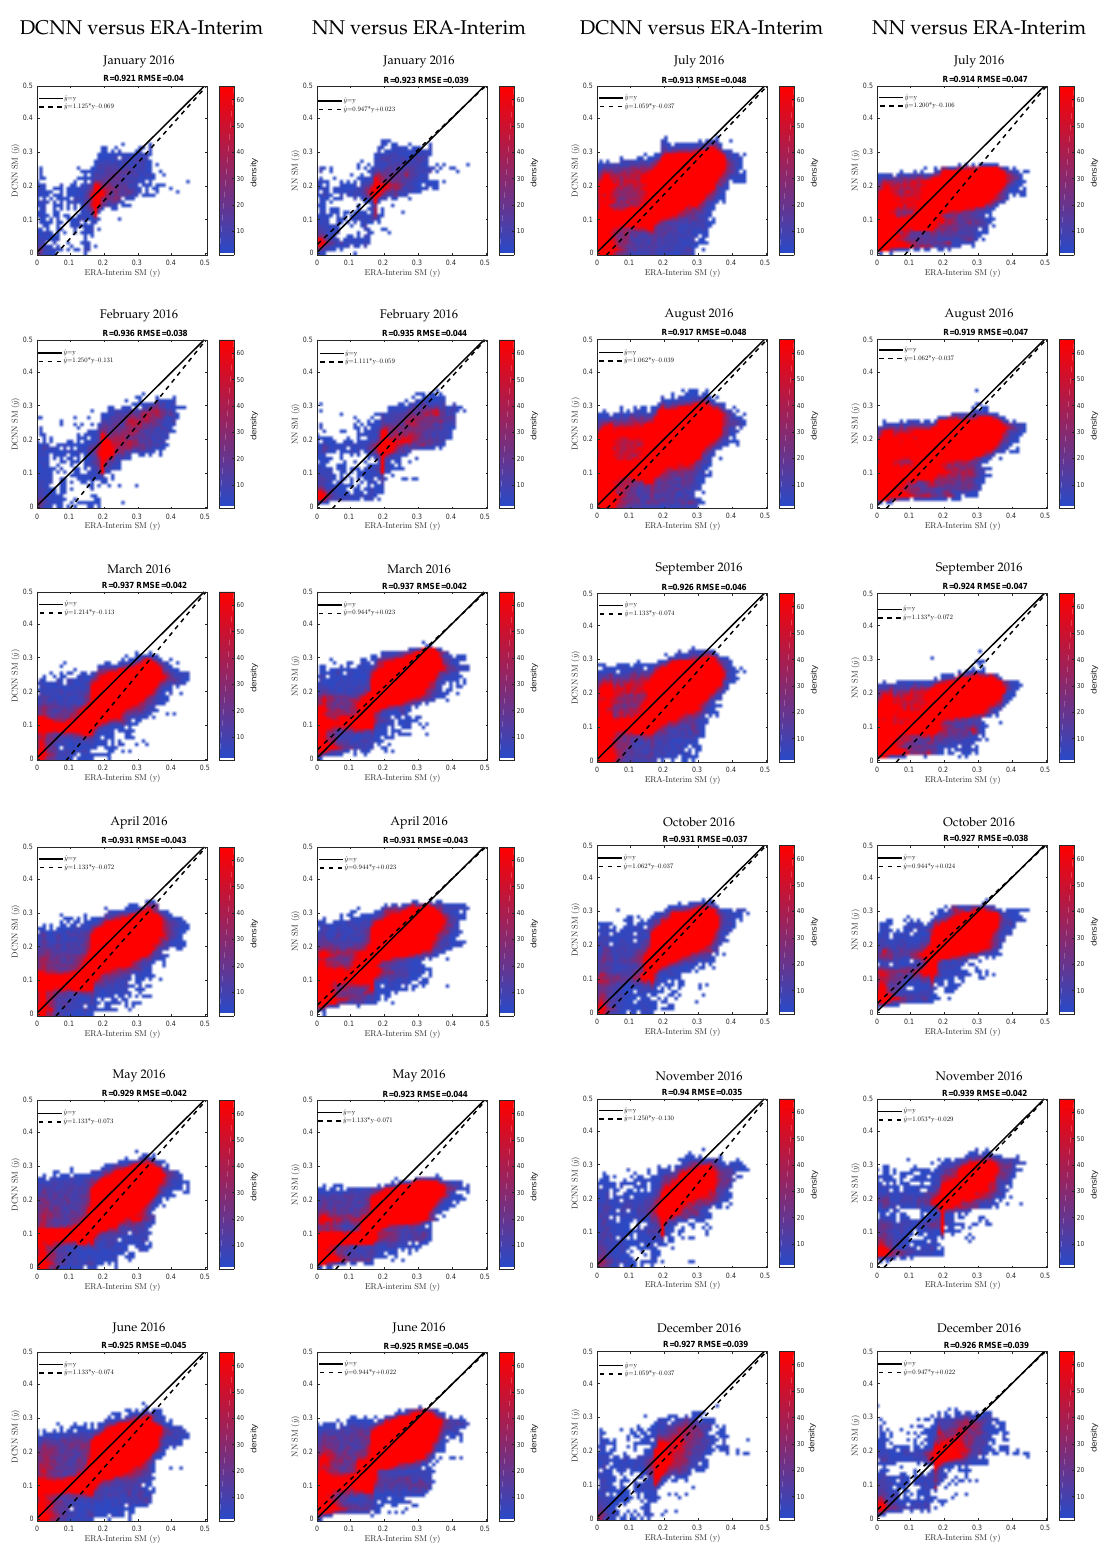
Figure 10. Scatter plot in density of the retrieved SM by DCNN versus ERA-Interim SM (the first and third column) and NN versus ERA-Interim SM (the second and fourth column) when SMOS ascending overpass in the testing phase. The solid line represents the ideal retrieval results, while the dashed line represents the